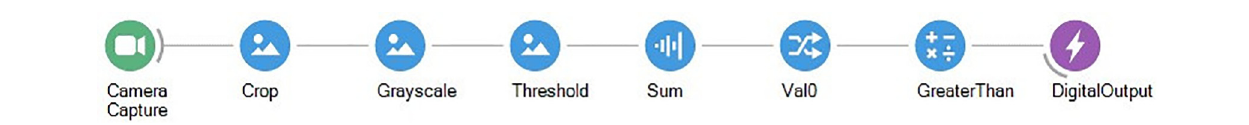
FIGURE 9 | Bonsai workflow for triggering a digital output based on a region of interest.